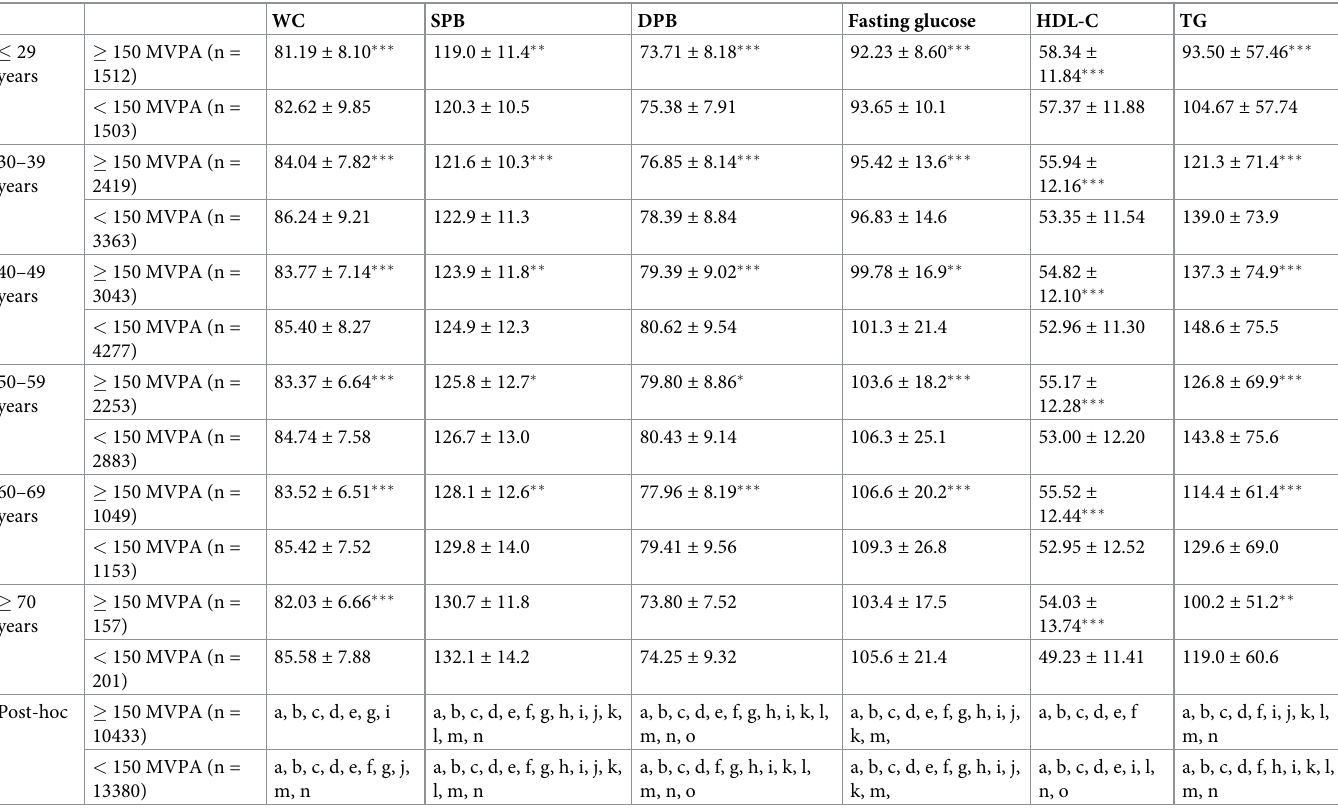
Table 2. Metabolic syndrome risk factors according to ages